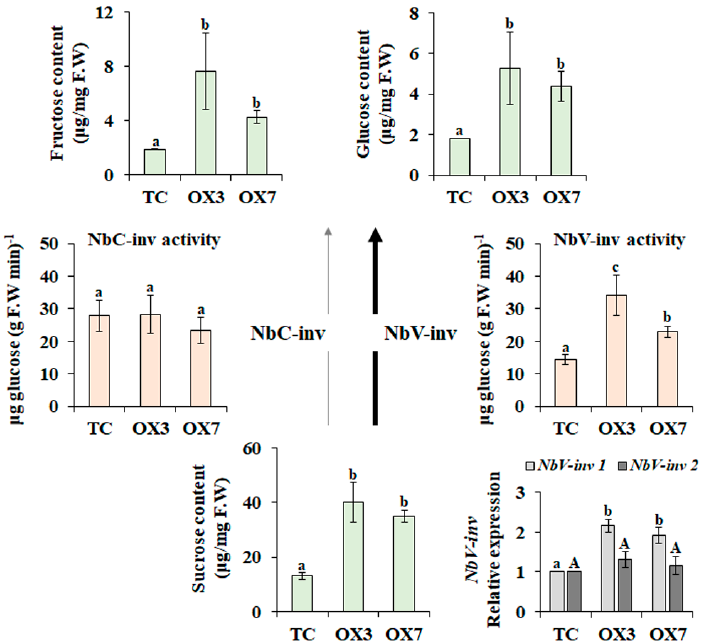
Figure 2. Sucrose metabolism in BrbZIP-S -overexpressing N . benthamiana plants (OX3 and OX7 lines). Total content of sucrose, glucose, and fructose was determined. The activities of vacuolar invertase (NbV-inv) and extracellular invertase (NbC-inv) were determined. Normalized expression levels of NbV-inv 1 and 2 were expressed as relative to transgenic control (TC) plants. Means ( ± SE) with different letters are significantly different, according to Duncan’s multiple range test (<0.05).